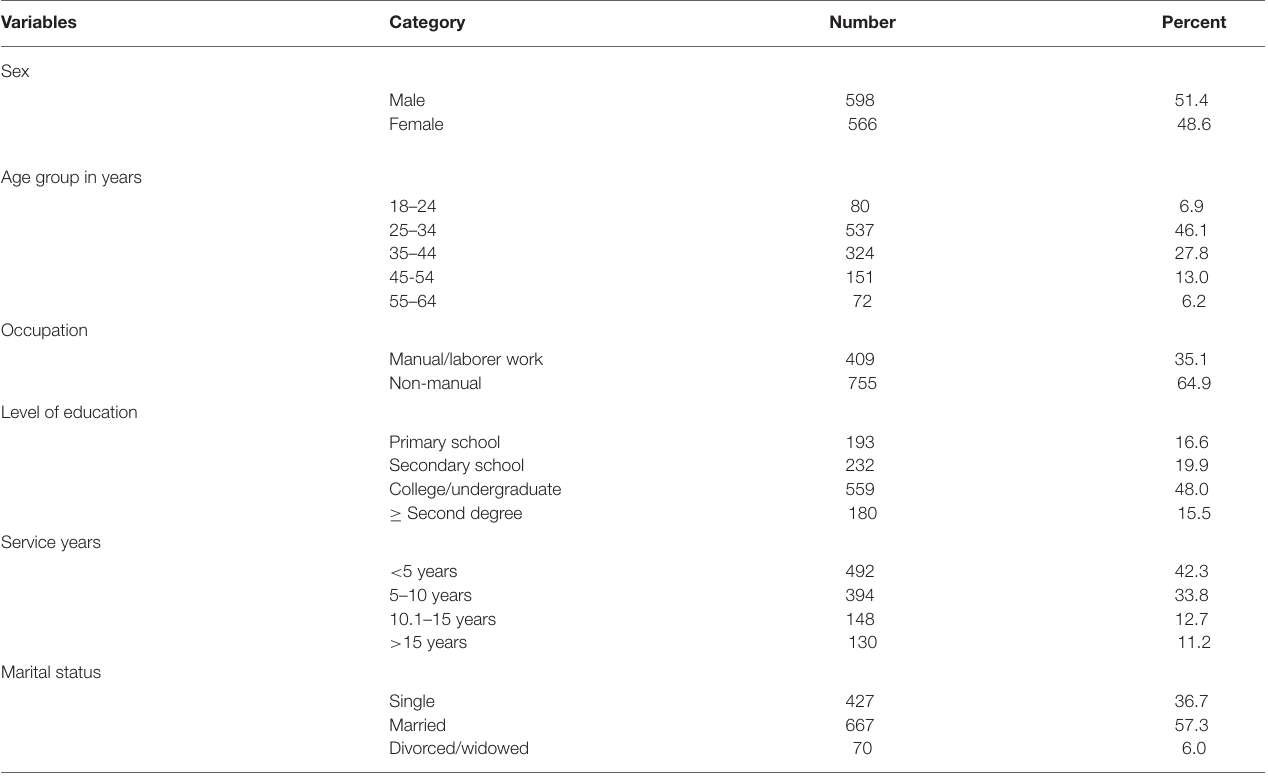
TABLE 1 | Socio-demographic characteristics of the study participants in Eastern Ethiopia, 2019 ( n = 1,164). Variables